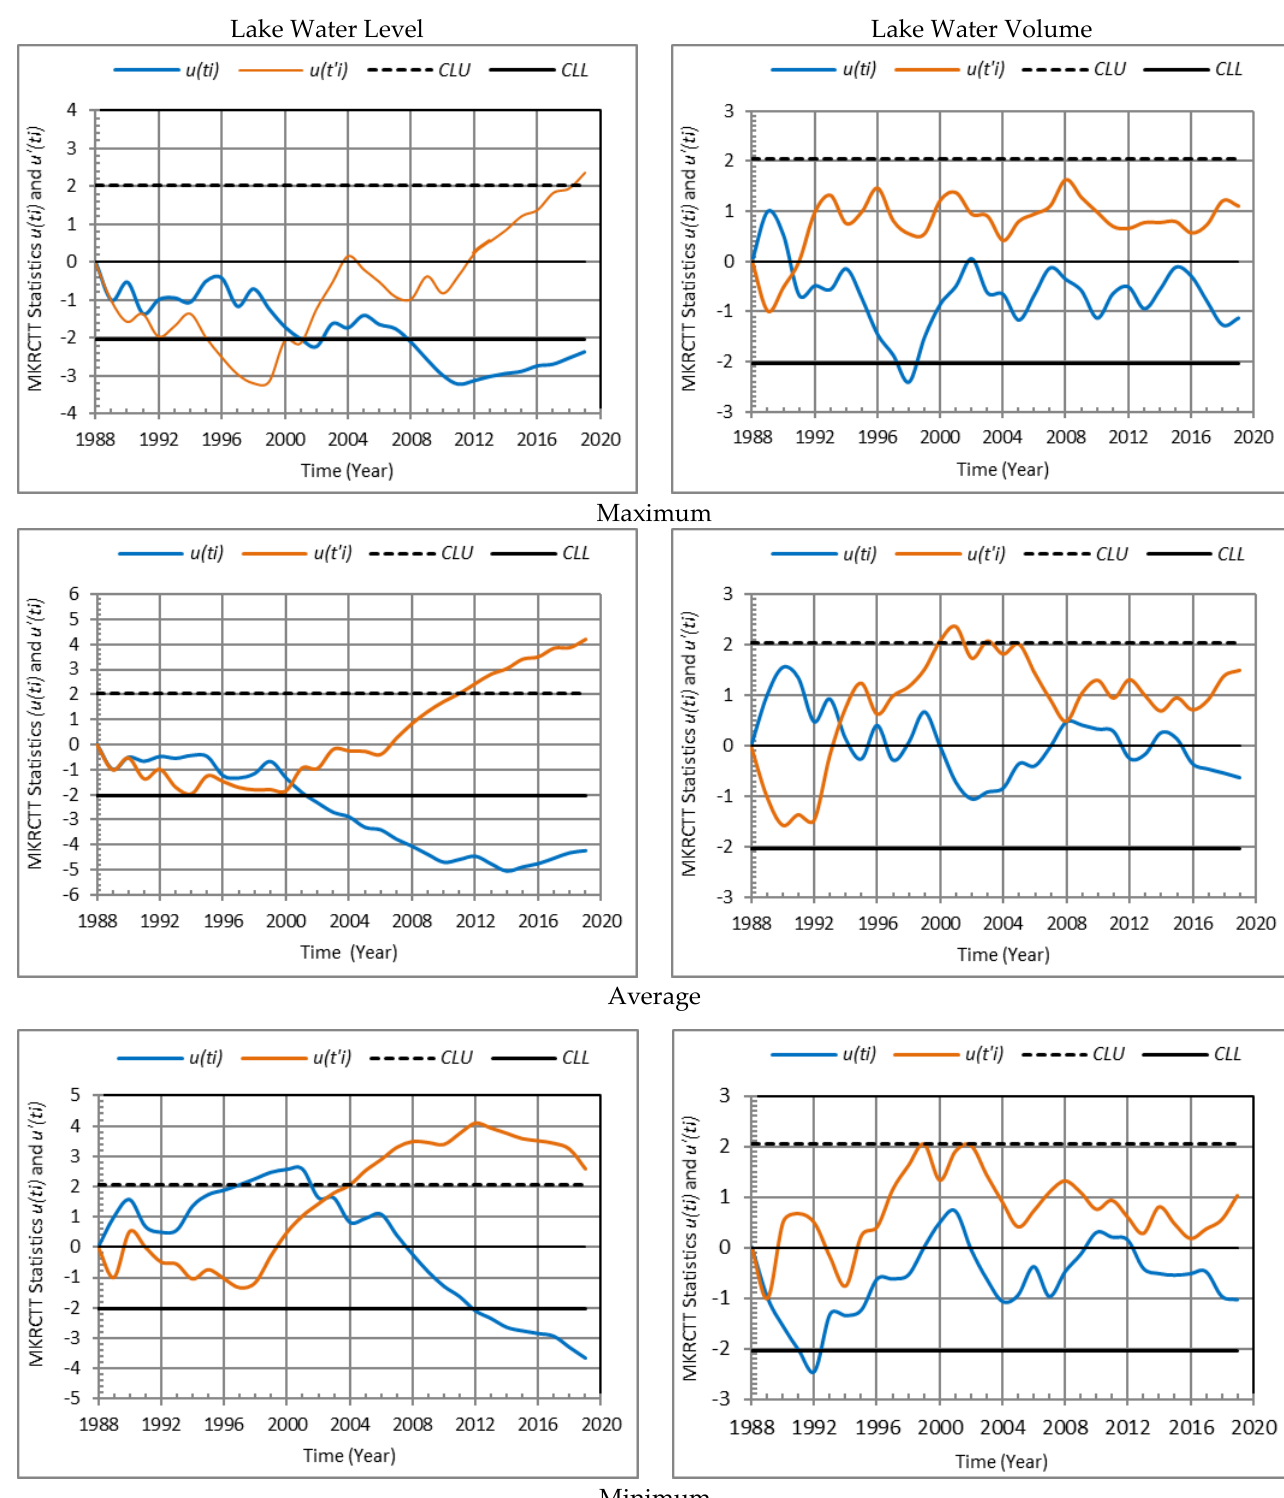
Figure 7. MKRCTT results for the LWL and LWV series. 𝑢(𝑡 𝑖 ) = calculated Mann-Kendall rank correlation trend test statistic; CLU = upper confidence limit; CLL = lower confidence limit.